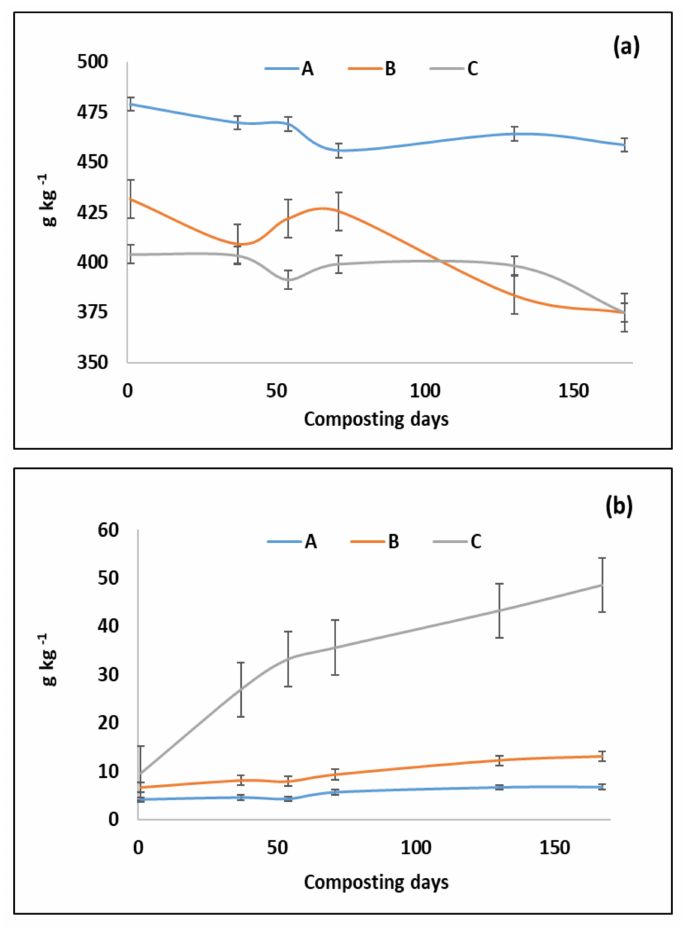
Figure 3. Changes in: ( a ) TOC and ( b ) TN during composting of willow chips [g kg − 1